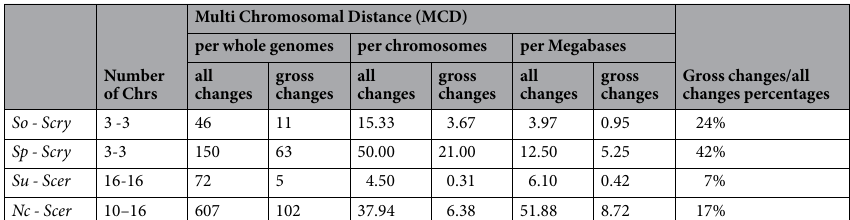
Table 2. Comparisons of multi chromosomal distances (MCDs) among the species. The data indicate that the chromosomes of fission yeasts bore more gross rearrangements than the chromosomes of budding yeasts. Values were estimated by GRIMM 15 using the data of LCBs extracted from the pairwise whole genome alignments created by Mauve aligner 49 . Since GRIMM estimates optimal rearrangement scenarios by transforming one genome to another via rearrangement events, the given values in the table correspond to one genome. For example MCD values per chromosomes in the case of So – Scry correspond to 3 chromosomes not 6. So: S. octosporus; Scry: S. cryophilus; Sp: S. pombe; Su: S. uvarum; Scer: S. cerevisiae; Nc: N. castelli . Chrs: chromosomes. All changes mean that we considered every rearrangement events regardless of the sizes and positions of the concerning LCBs. While in the case of gross changes we excluded the subtelomeric regions because these are inclined to undergo rearrangements and just the LCBs > 20 000 nucleotides were